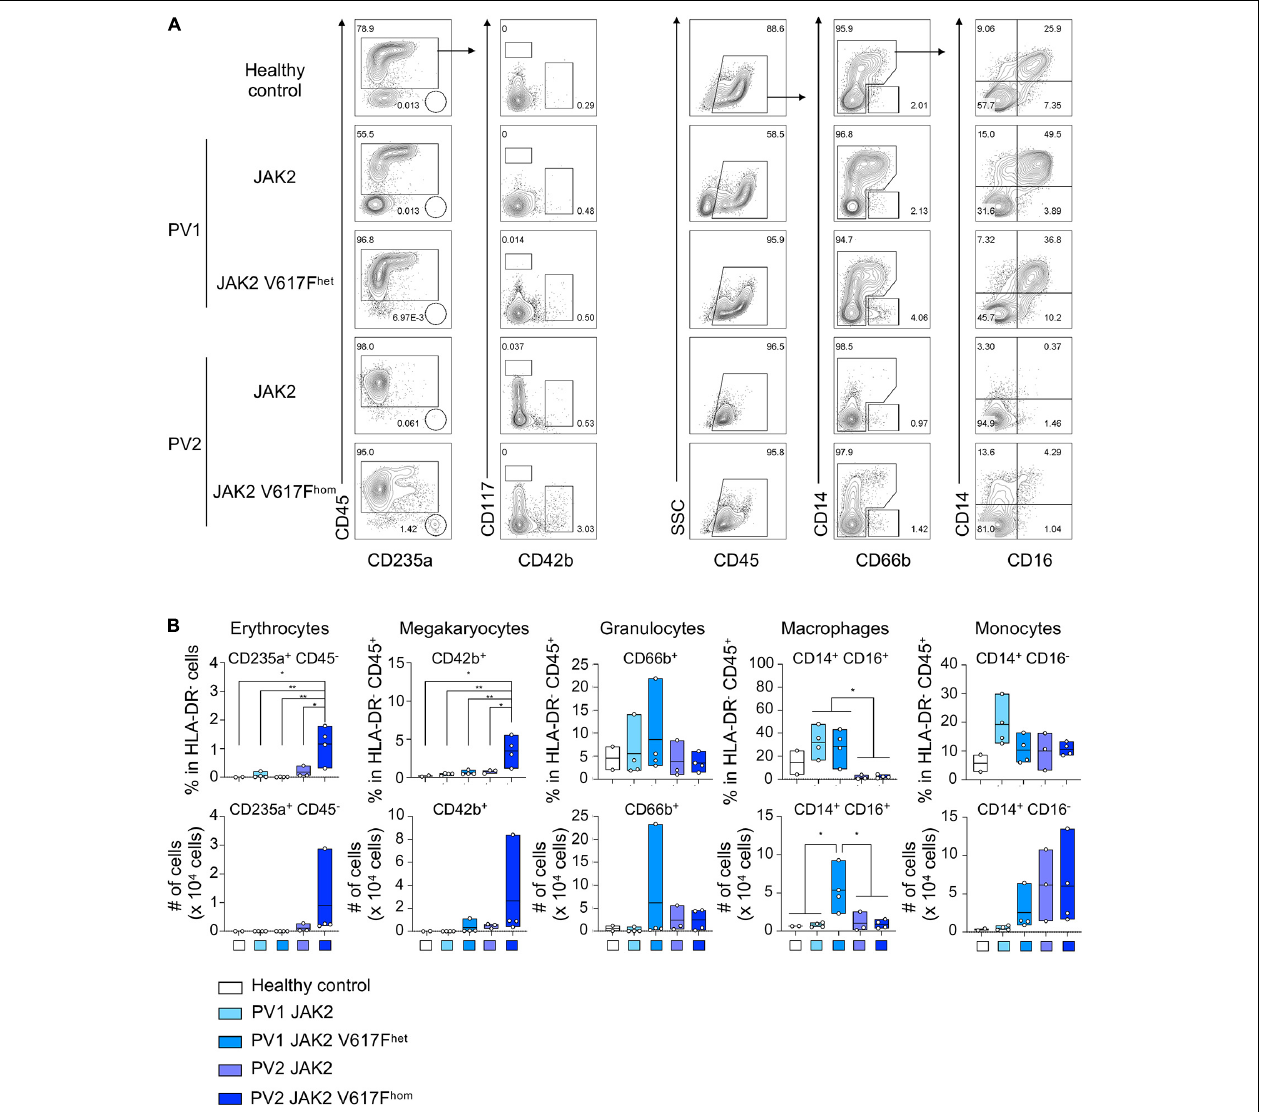
FIGURE 3 | Erythropoiesis and megakaryopoiesis upon differentiation of JAK2 V617F hom iPS cells. (A) JAK2 V617F het and JAK2 V617F hom iPS cells of patients PV1 and PV2, respectively, were differentiated as in Figure 1A and HLA-DR − cells on day 8–9 of differentiation were analyzed for erythrocytes, megakaryocytes and myeloid cells (granulocytes, monocytes and macrophages) by flow cytometry. Cells without mutation (JAK2) and cells of healthy donor (healthy control) were used as controls. Representative flow cytometry plots are shown. (B) Quantification of flow cytometry data of (A) . n = 2–4, mean ± SD; * p < 0.05, ** p < 0.005, one-way ANOVA with Tukey’s multiple comparisons